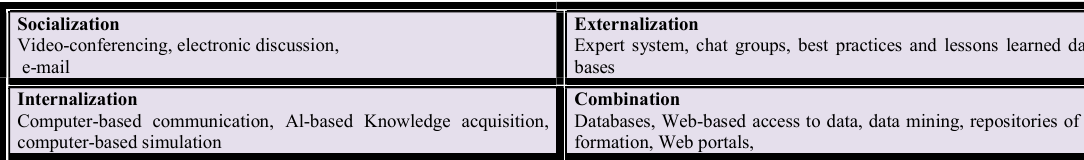
Fig. 3. Summarized technologies that help to Conversion of knowledge (Fernandez & Sabherwal, 2015)